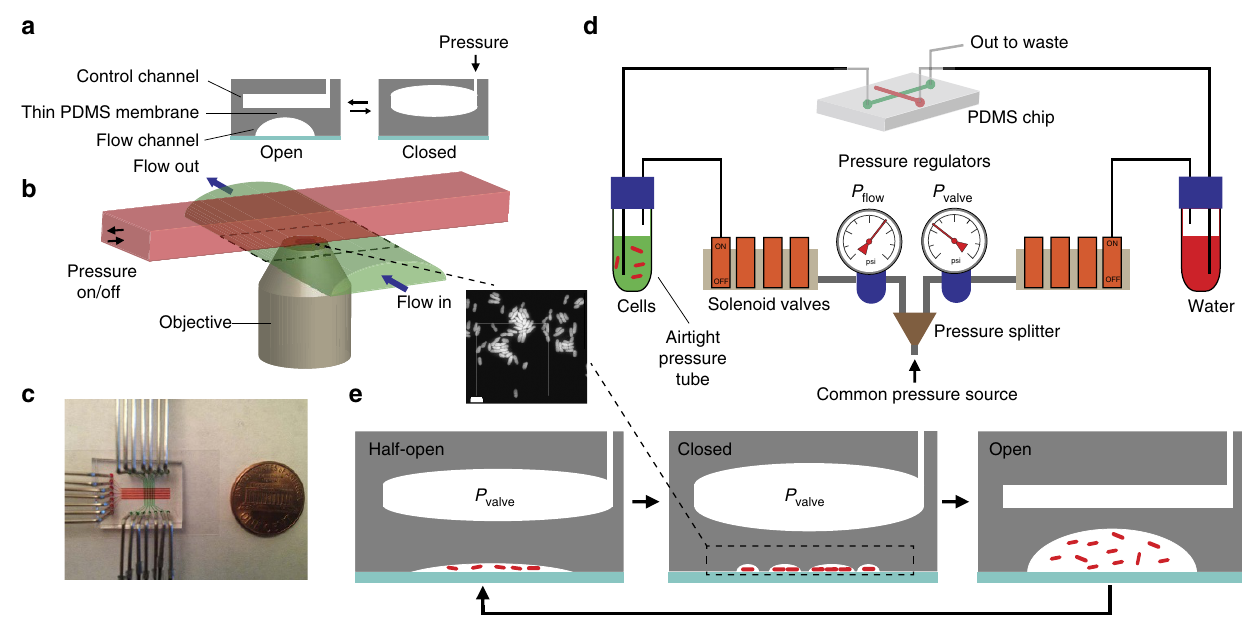
Figure 1 | MACS set-up and workflow. ( a ) Cross-sectional schematics of the PDMS (grey) based Quake valve. A PDMS membrane separates a dead-end control channel from a dome-shaped flow channel. As the control channel is pressurized, the flexible membrane collapses onto the glass coverslip (cyan) to close the flow channel—akin to stepping on a garden hose. The flow channel rapidly re-opens as the pressure is removed. The valve can thus be actuated practically indefinitely. ( b ) Three-dimensional depiction of the valve. Control (red) and flow (green) channels run perpendicular to each other. We image underneath the region where the two channels intersect (that is, ‘valving’ intersection), which is outlined by dashed lines. ( c ) Photograph of the MACS chip with control and flow channels filled with red and green dyes, respectively. ( d ) Independently controlled manual pressure regulators allow introducing pressurized air into the airtight pressure tubes (PT) to push liquid out for inducing flow of cells (green) and pressurizing the control channel (red) on the PDMS chip (via P flow and P valve , respectively). Computer-controlled solenoid valves are used to switch P flow and P valve , on or off. ( e ) MACS capitalizes on cycling between three distinct states of the valve (flow direction away from the page): Half-open state ( P flow : on, P valve : on) is a high-resistance, low flow- rate state achieved by a certain combination of P flow and P valve , where cells move as a monolayer underneath the PDMS membrane. When flow is stopped, the closed state ( P flow : off, P valve : on) is achieved with the PDMS membrane fully sealing against the coverslip to immobilize the cells (also shown are ‘water pockets’ forming around the cells) for taking fluorescence (inset, scale bar (white), 2 m m), and/or phase contrast (Supplementary Fig. 1) images of cells. Finally, the open state is executed ( P flow : on, P valve : off) which is a low-resistance, high flow-rate state. The high flow rate enabled by the open state rinses the field of view and permits rapid exchange of liquid allowing for introduction of new cells that were not affected by photobleaching during imaging. Fast cycling through this sequence allows for taking multiple snapshots towards building extensive statistics (Supplementary Movie